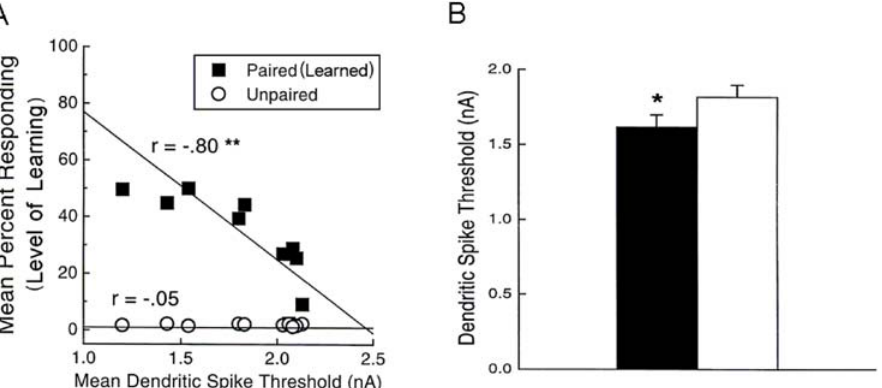
Figure 13. Learning-specific membrane excitability after 1 day of classical conditioning (A), and 1 month after 3 days of classical conditioning (B). A. Strong linear relationship between level of conditioning and mean dendritic spike threshold (at least 2 measures per rabbit) for trained rabbits ( filled squares , r = 2 0.80, p , 0.01) relative to control rabbits ( open circles , r = 2 0.05, p . 0.8). Note that better trained animals have lower threshold (more excitable) PC dendrites. B. Mean dendritic spike thresholds showing a significantly lower threshold in cells ( n =61) from trained rabbits (black bar) than in cells ( n =47) from control rabbits (white bar). * p , 0.05. Figures are from Schreurs et al. [21].